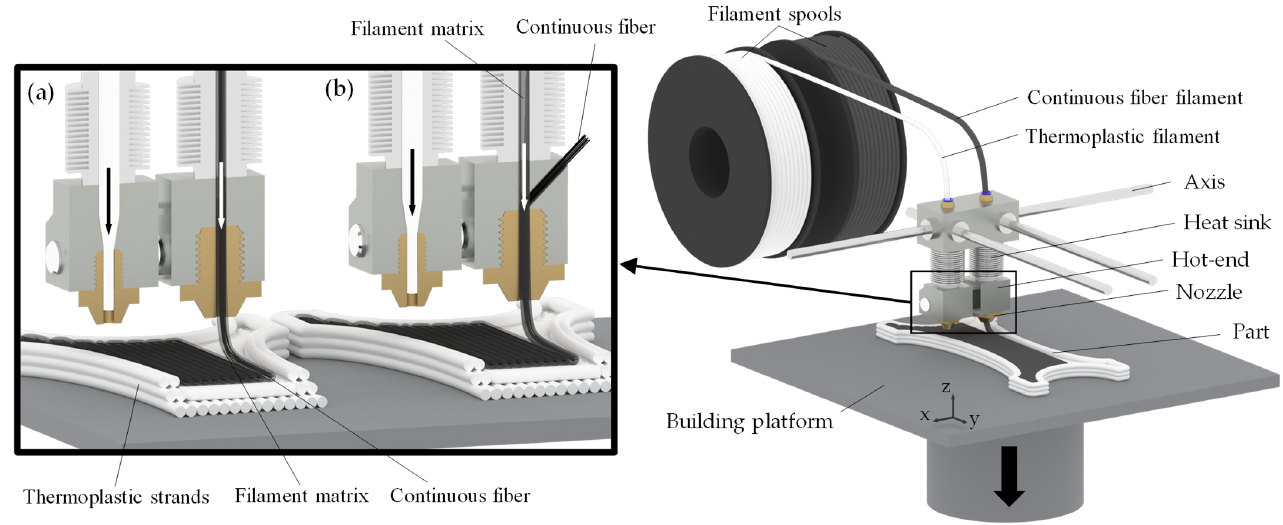
Figure 1. Schematic representation of the established approaches for introducing continuous fibers in the MEX process: ( a ) with pre-impregnated fiber filament; ( b ) with fiber impregnation in the print head.